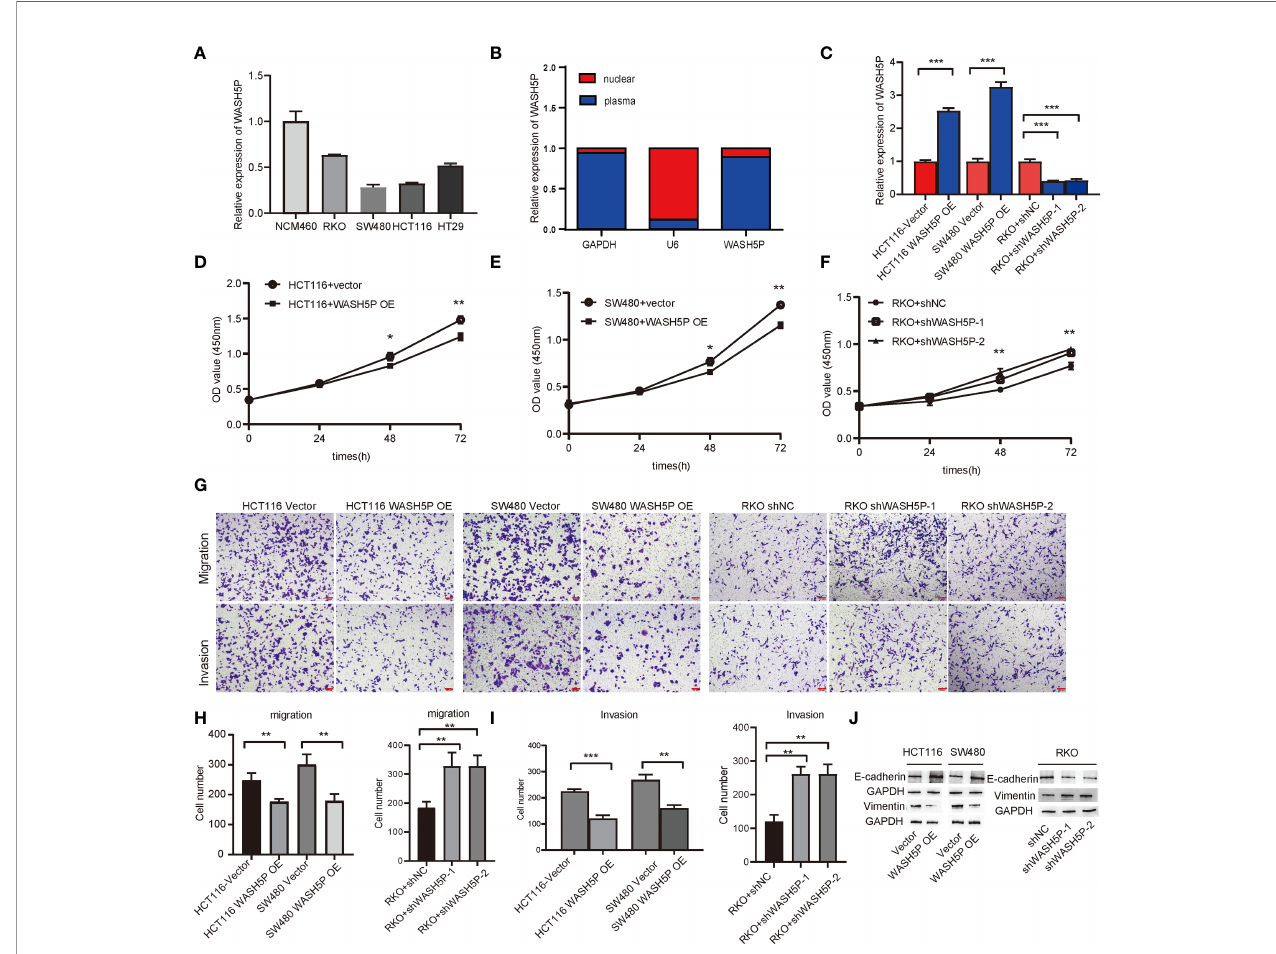
FIGURE 2 | LncRNA WASH5P inhibits the development of CRC in vitro . (A) LncRNA WASH5P expression was measured in the normal colon cell line NCM460 and four CRC cell lines by real-time PCR. (B) Real-time PCR was performed to examine lncRNA WASH5P levels in the cytoplasm and nucleus, respectively. (C) Knockdown and overexpression ef fi ciency were con fi rmed by real-time PCR in different CRC cell lines. ***. Correlation is signi fi cant at the 0.001 level. (D, E) CCK-8 assay was performed in HCT116 and SW480 cells transfected with lncRNA WASH5P or a vector. Cell viability was measured from an absorbance reading at 450 nm. Data were expressed as relative viability (%) calculated: [A450(treated) − A450 (blank)]. *. Correlation is signi fi cant at the 0.05 level, **. Correlation is signi fi cant at the 0.01 level. (F) CCK-8 assay was performed in RKO cells transfected with shWASH5P (WASH5P shRNA) or shNC (control shRNA). **. Correlation is signi fi cant at the 0.01 level. (G – I) In vitro invasion and migration assays were performed using HCT116, SW480, and RKO cells. Cells were photographed under a light microscope and counted from fi ve random microscopic fi elds (×200) per insert in triplicate. **. Correlation is signi fi cant at the 0.01 level, ***. Correlation is signi fi cant at the 0.001 level. Scale bars represent 100 µm. (J) Protein level of epithelial marker (E-cadherin) and mesenchymal marker (vimentin) were measured by Western blot in HCT116 and SW480 cell after WASH5P transfection, compared with vector; Immunoblots indicated the expression levels of epithelial (E-cadherin) and mesenchymal (vimentin) markers in RKO cells after being transfected with shWASH5P and shNC. GAPDH was used as a loading